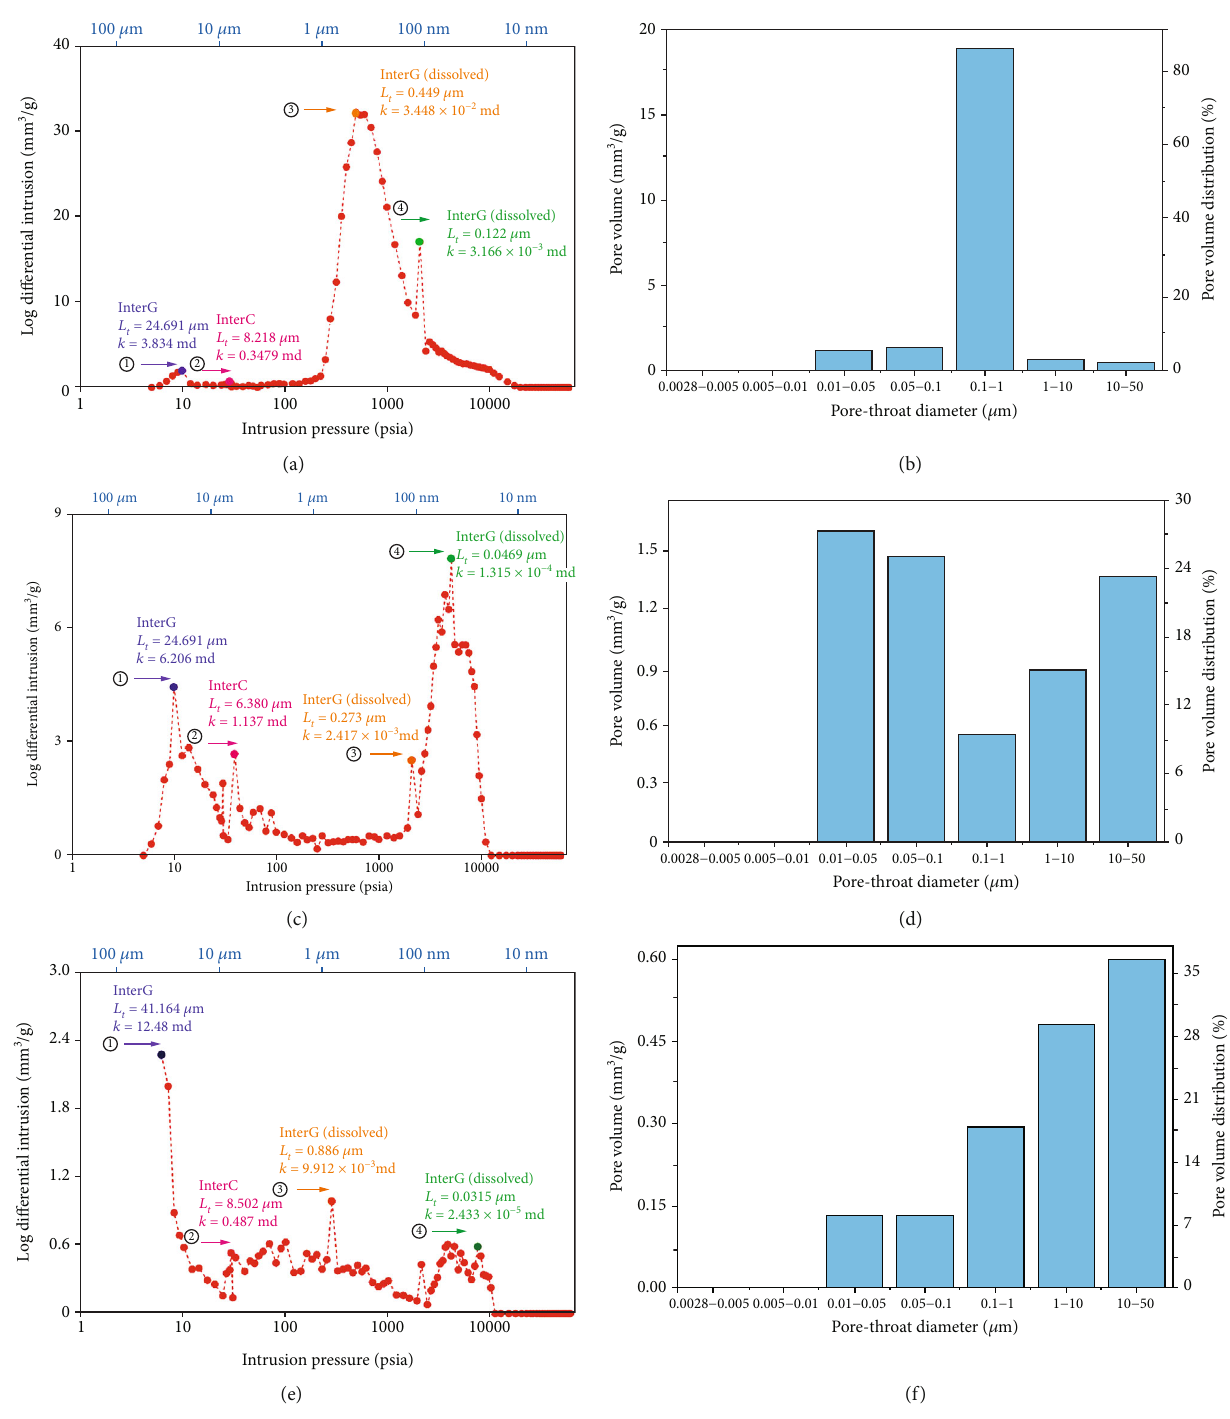
Figure 8: Three typical samples with di ff erent types of PSD ((a, b) SGT 4-30-E, Type I; (c, d) SGT 6-49-A, Type II: (e, f) SHY 3-098, Type III) (see Section 4.2 and Table 2 for description of the “ Types ” ). (a), (c) and (e): log di ff erential intrusion vs. intrusion pressure, with each in fl ection point corresponding to a connected pore network. (b), (d) and (f): volume and percentage of di ff erent intervals of pore-throat